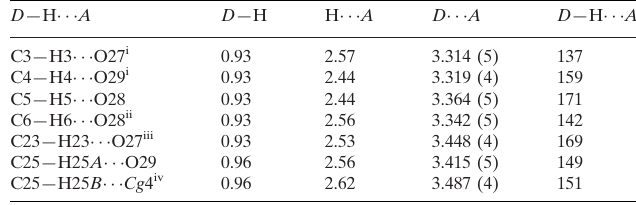
Hydrogen-bond geometry (A˚ , (cid:4) ). Cg 4 is the centroid of the C18–C23 ring.